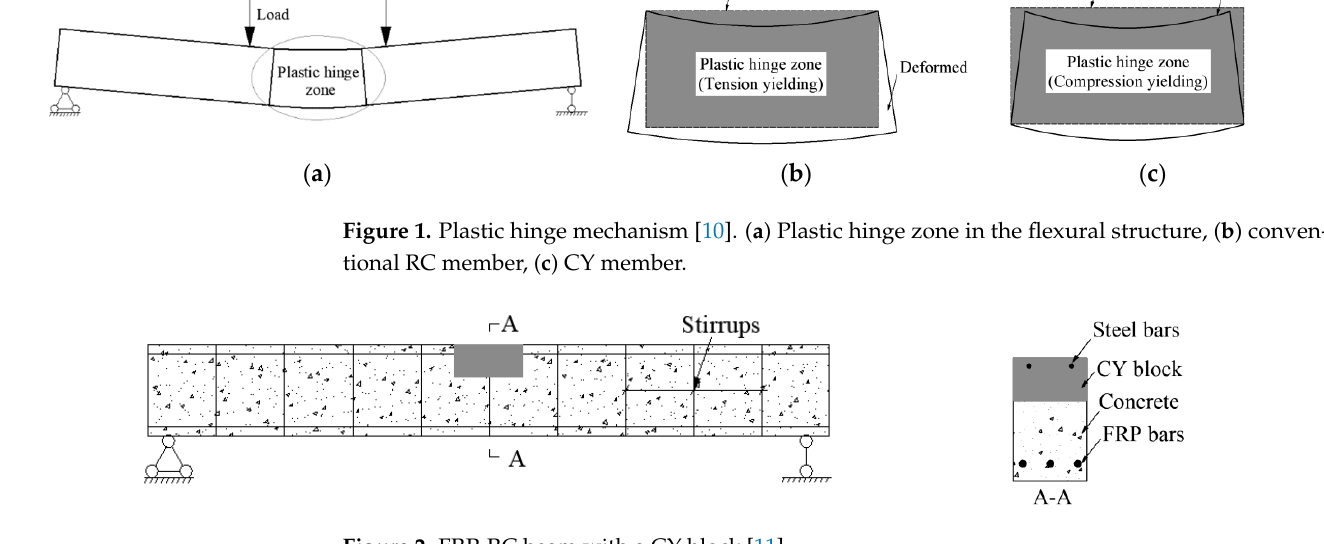
Figure 2. FRP-RC beam with a CY block [11].